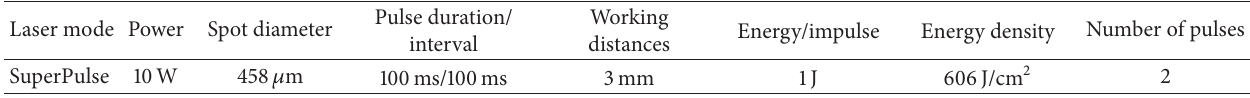
Table 1: Applied CO 2 laser mode and